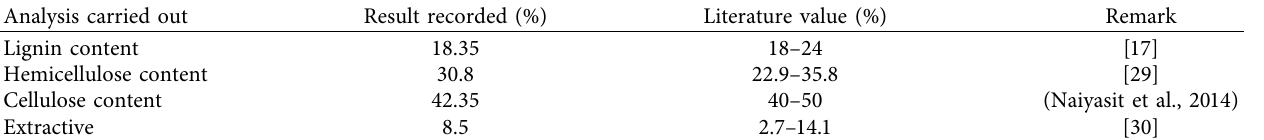
Table 3: Comparison of this work with literature value for component characterization.